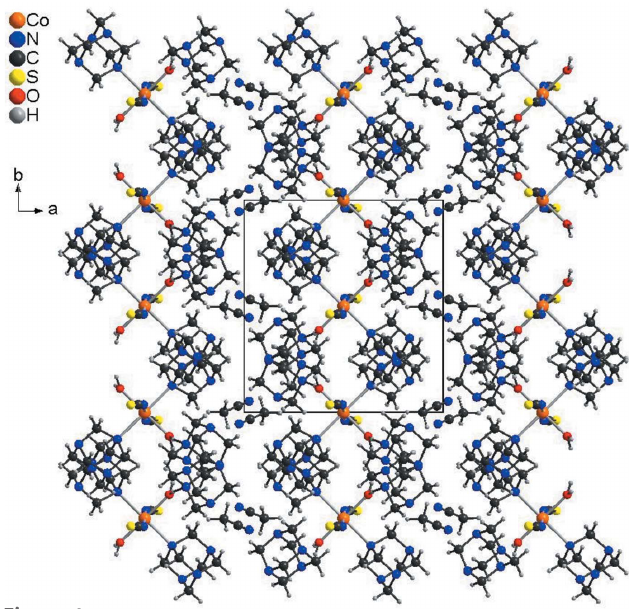
Figure 4 Crystal structure of the title compound viewed along the c -axis.